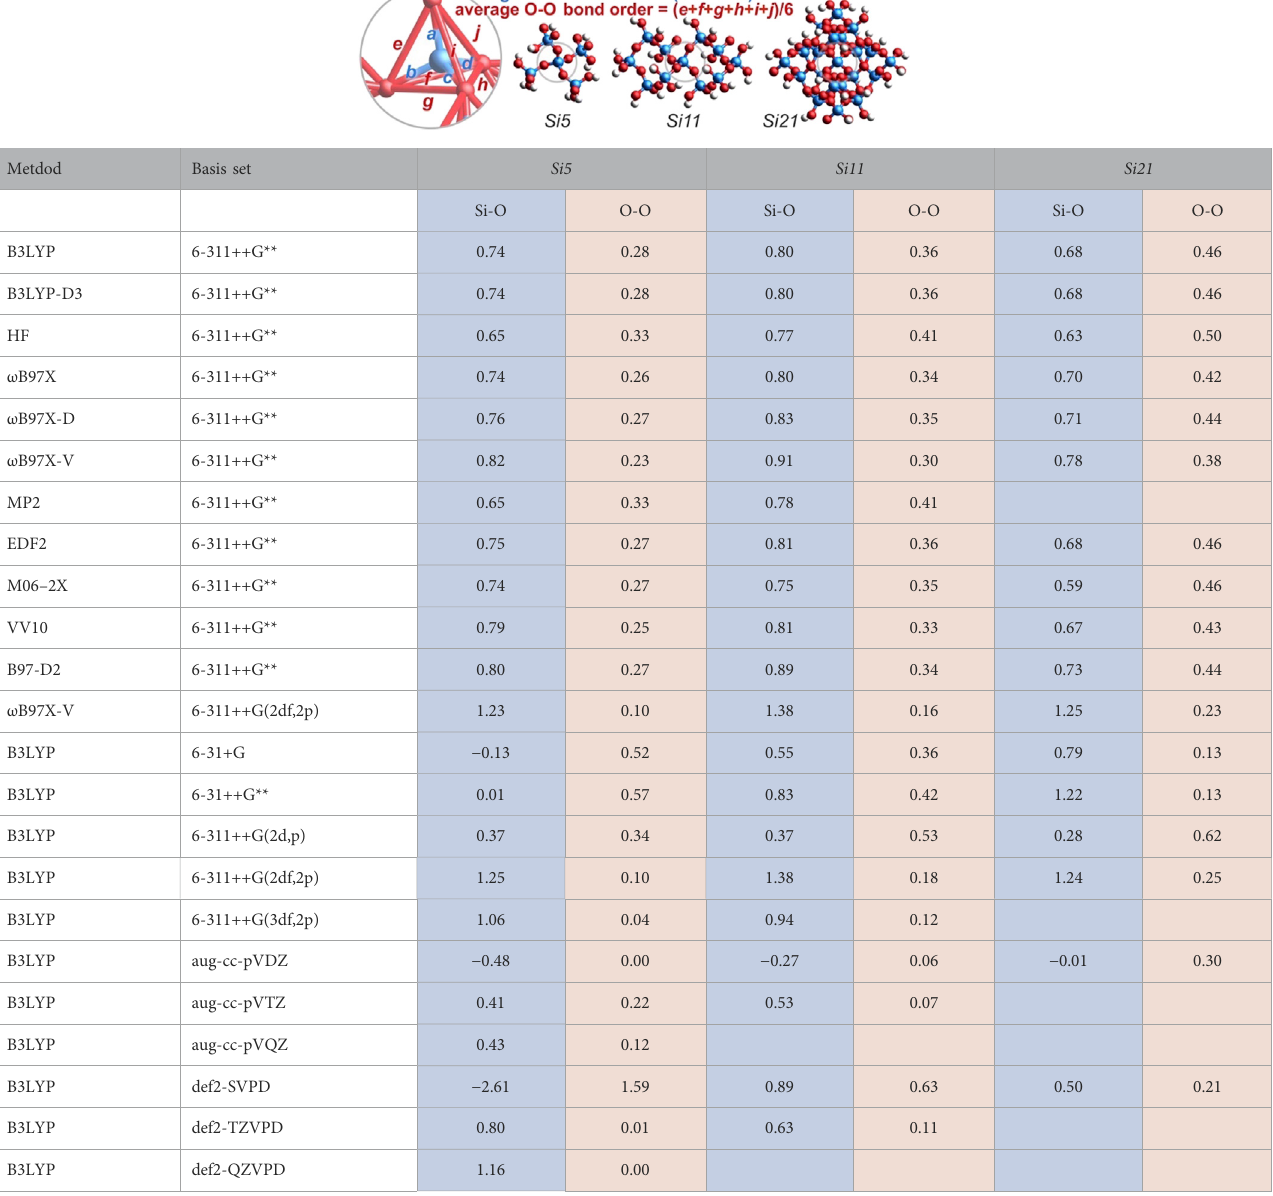
TABLE 1 Average computed Mulliken bond orders for the central SiO 4 unit within the Si5 (Si 5 O 16 H 12 ), Si11 (Si 11 O 32 H 20 ), and Si21 (Si 21 O 56 H 28 ) clusters. Four bond order values are averaged for Si-O and six bond order values are averaged for O-O. (Not all computations converged).